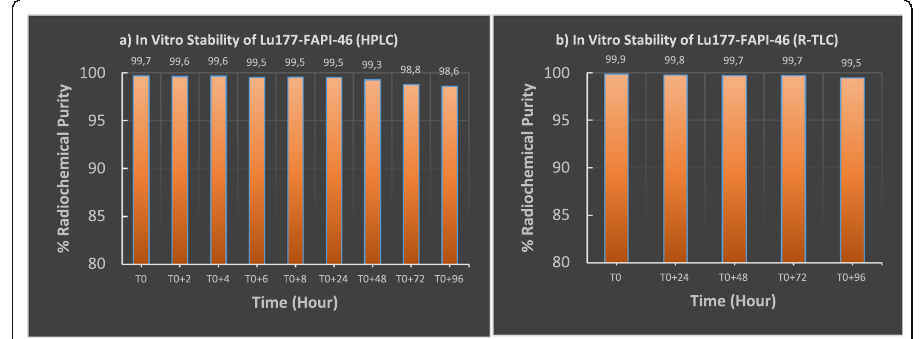
Fig. 7 Stability study of [ 177 Lu]Lu-FAPI-46. a Radiochemical purity results analyzed by R-HPLC: T0, T0 + 2 h, T0 + 4 h, T0 + 6 h, T0 + 8 h, T0 + 24 h, T0 + 48 h, T0 + 72 h, T0 + 96 h. , b Radiochemical purity results analyzed